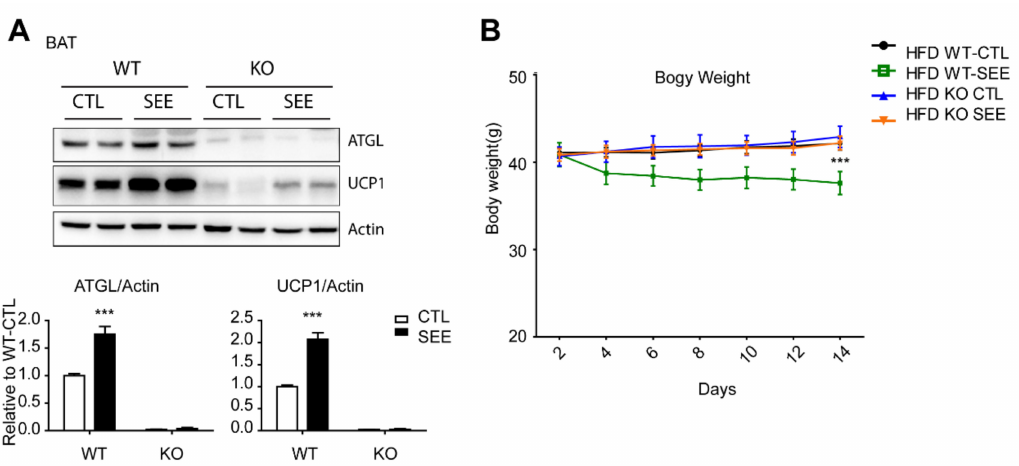
Figure 6. Adipocyte-specific ATGL knockout attenuates e ff ects of SEE on body weight in high fat diet induced obesity model. ( A ) Immunoblot analysis of ATGL and UCP1 in BAT of WT controls and adipocyte-specific adipose triglyceride lipase (ATGL) knockout (KO) mice, fed HFD for 8 weeks and treated with vehicle (CTL) and SEE (400 mg / kg) for two weeks. ( B ) Body weight monitoring of WT controls and adipocyte-specific ATGL KO mice during SEE treatment ( n = 6, means ± SEM, *** p <